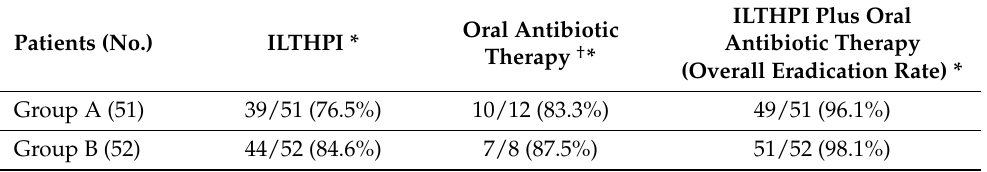
Table 4. The overall eradication rate of intraluminal therapy plus oral antibiotic therapy.